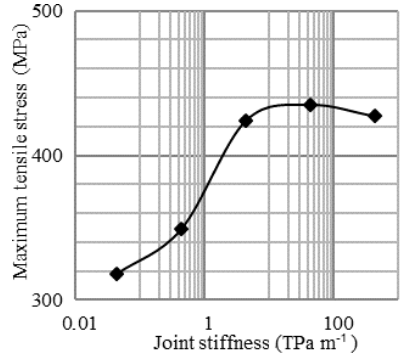
Figure 11. Maximum tensile stress vs. contact stiffness (without coating).